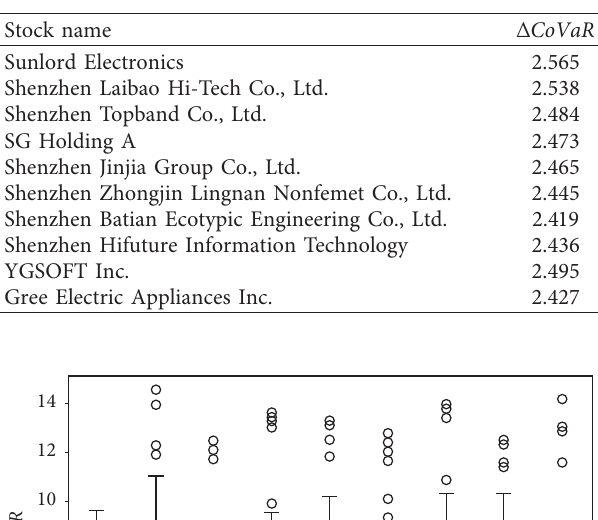
Figure 2: Histogram of ∆ CoVaR . Table 2: 10 stocks with the smallest ∆ CoVaR .